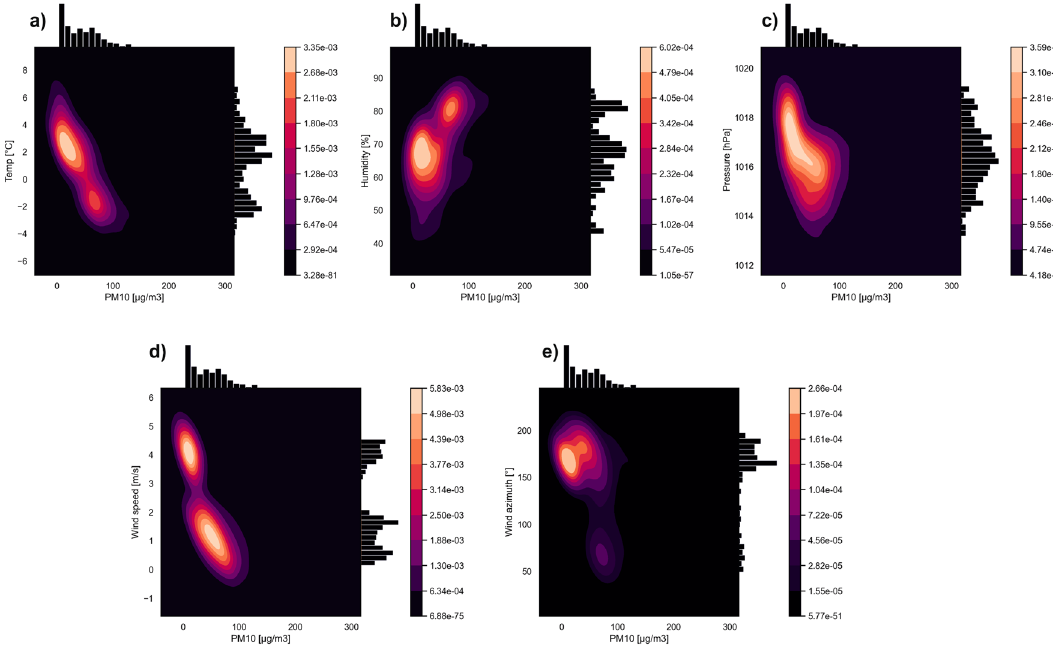
Figure 3. Multivariate kernel density estimations of PM10 and temperature ( a ), humidity ( b ), pressure ( c ), wind speed ( d ), wind azimuth ( e ) on the 18th of